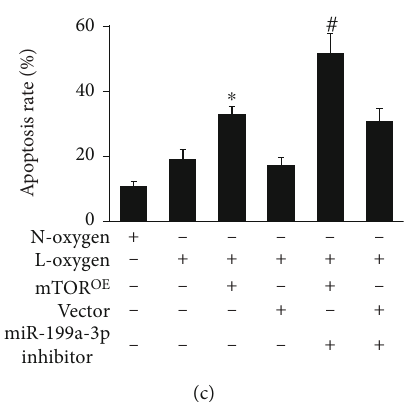
Figure 4: Overexpression of mTOR or miR-199a-3p inhibitor greatly aggravated cell injury. (a) The cell proliferation was measured after di ff erent treatments. (b) Flow cytometry was applied to evaluate cell apoptosis. (c) Cell apoptosis was quanti fi ed. ∗ P < 0 : 05 compared to group L-oxygen. # P < 0 : 05 compared to group L-oxygen+mTOR OE